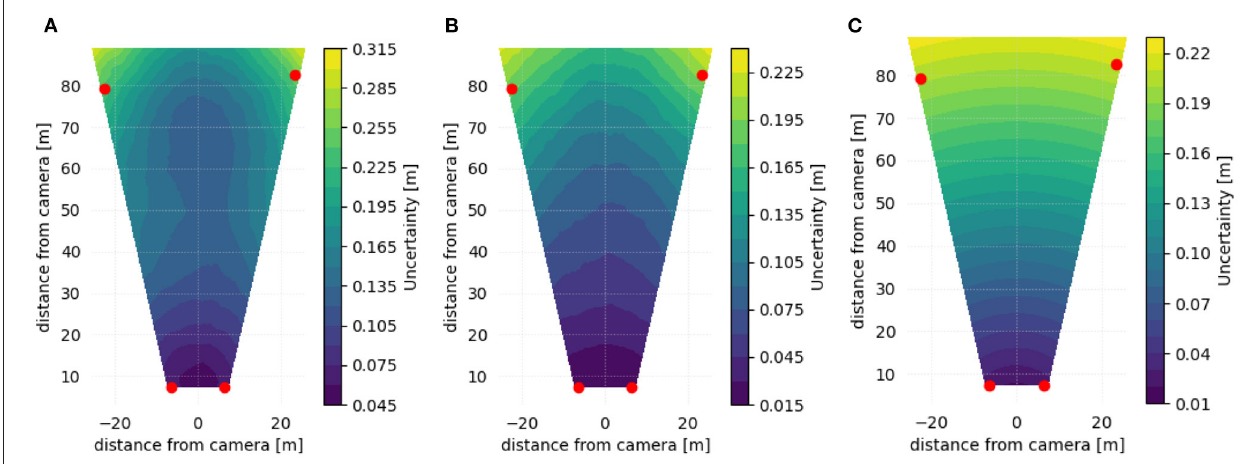
FIGURE 4 | 95th percentile contours of spatial uncertainty, resulting from perturbing only one input to the georeferencing calculation. Red dots indicate positions of GCPs. (A) Perturbations applied only to the physical ( x , y , z ) coordinates of each GCP. (B) Perturbations applied only to the pixel ( u , v ) coordinates of each GCP. (C) Perturbations applied only to the water surface elevation.